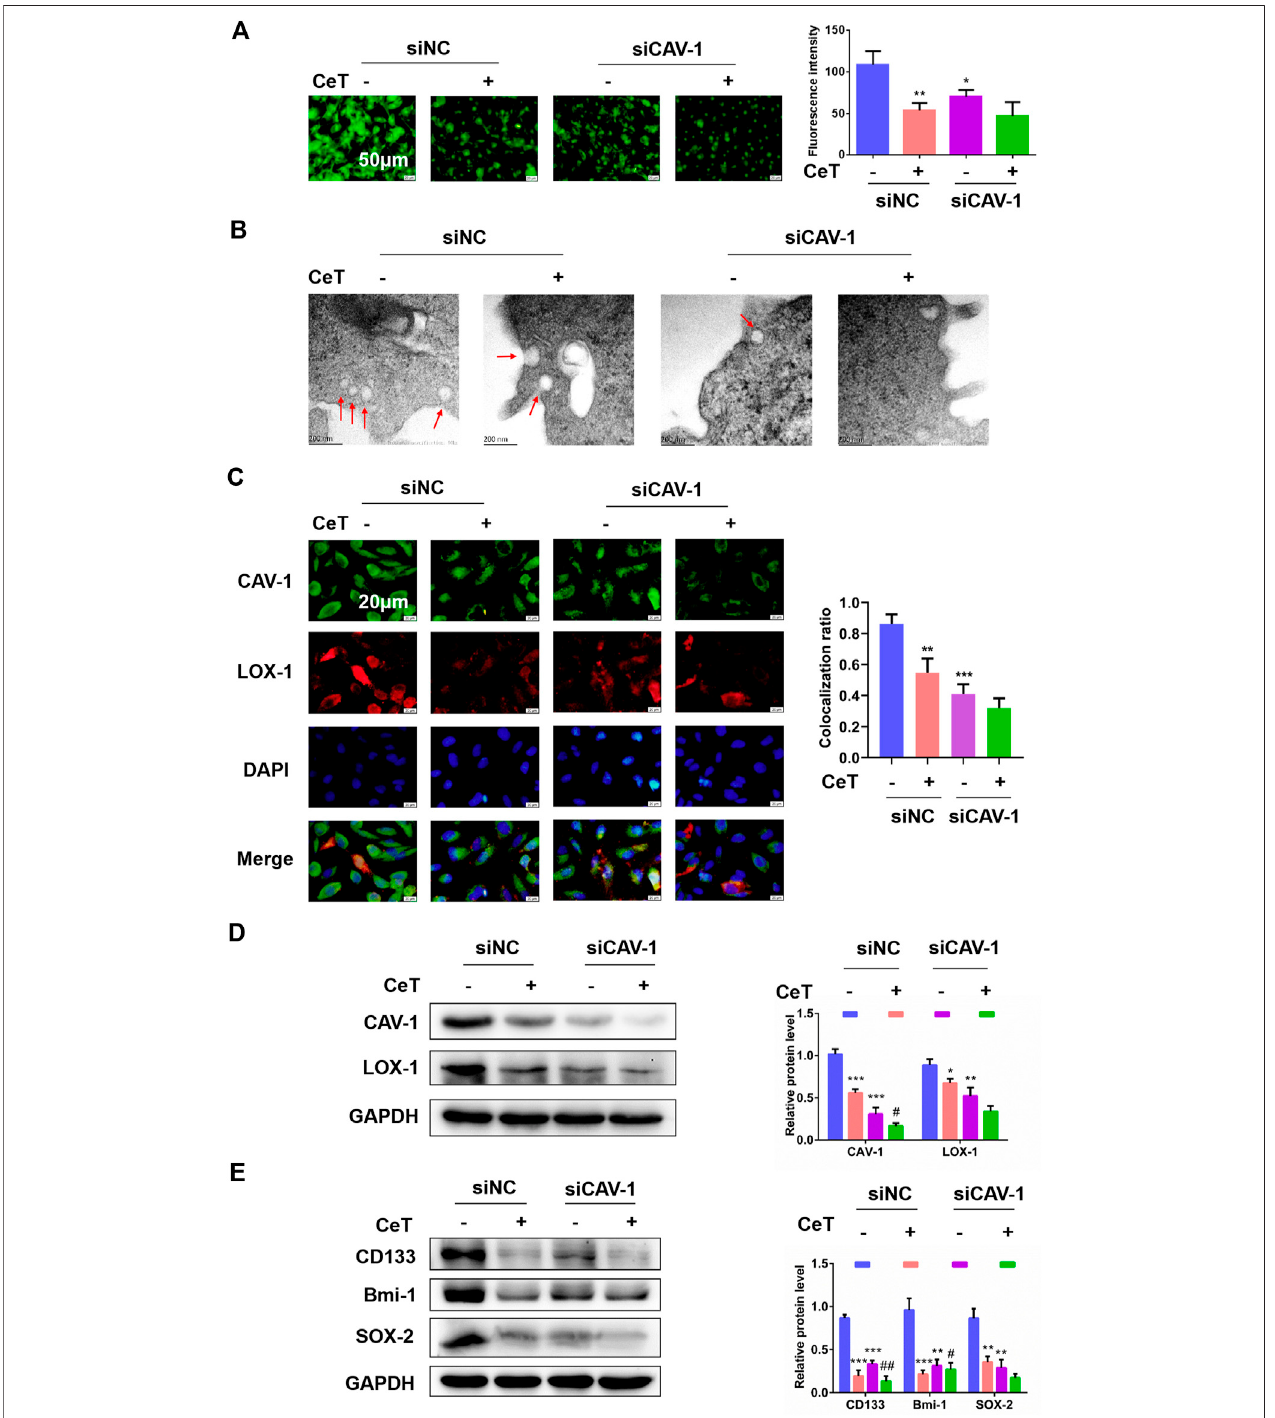
FIGURE 5 | Celastrol impaired lipid accumulation and stemness via CAV-1 (A) The BODIPY fl uorescence intensity was observed by using fl uorescent microscope after knockdown of CAV-1. Scale bar: 50 μ m (B) TEM assay con fi rmed that siNC cells displayed caveolae on the cellular surface, while few caveolae was present in siCAV-1 cells treated with CeT. Scale bar: 200 nm (C) Representative immuno fl uorescence staining showed the co-localization of CAV-1 and LOX-1 in 786-O cells transfected with siCAV-1. The Pearson ’ s correlation was shown in bar graph from three independent experiments (D) The levels of CAV-1 and LOX-1 were measured by western blotting (E) Western blotting of stemness-associated markers, including CD133, Bmi-1 and SOX-2. The data were shown as the mean ± SD of three replicates. * p < 0.05, ** p < 0.01, *** p < 0.001 vs. the control; # p < 0.05, ## p < 0.01 vs. the siCAV-1 cells.